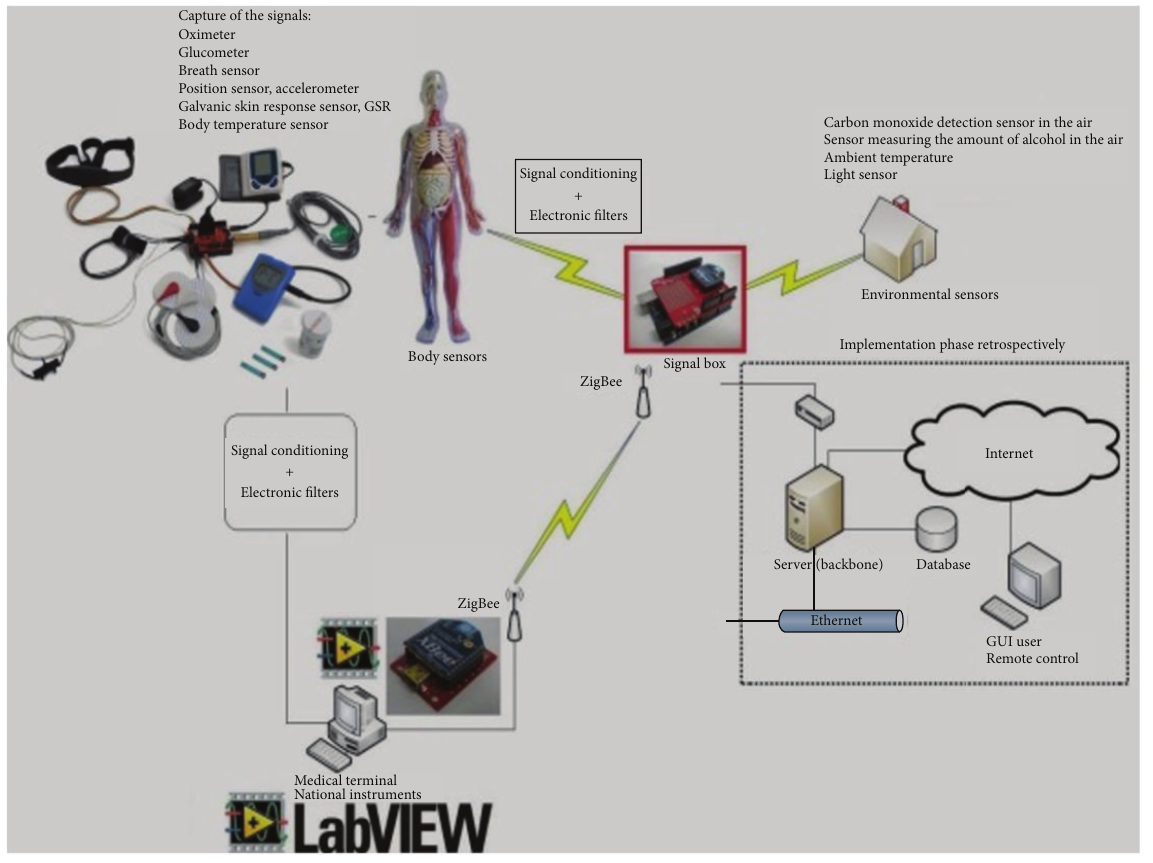
Figure 9: Block system diagram [14].